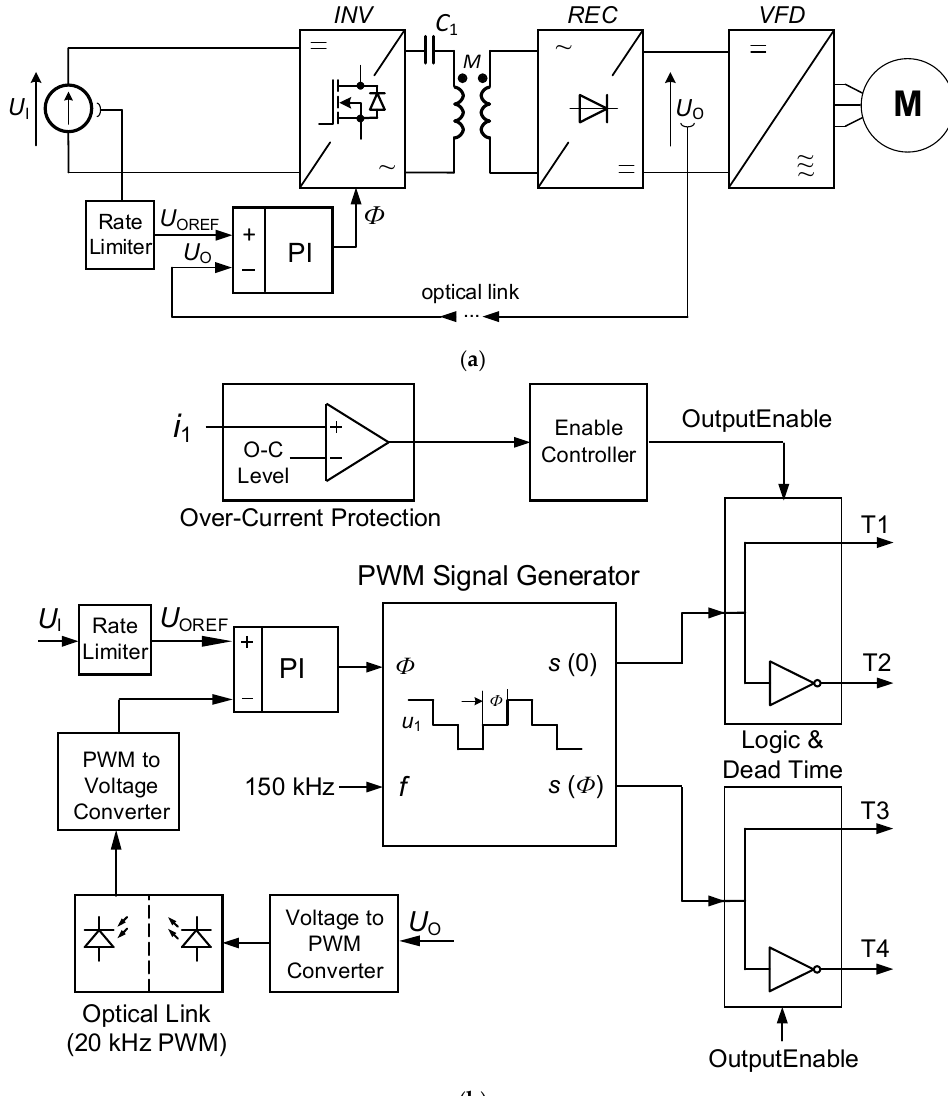
Figure 6. Control block diagrams: ( a ) simplified, ( b ) detailed.